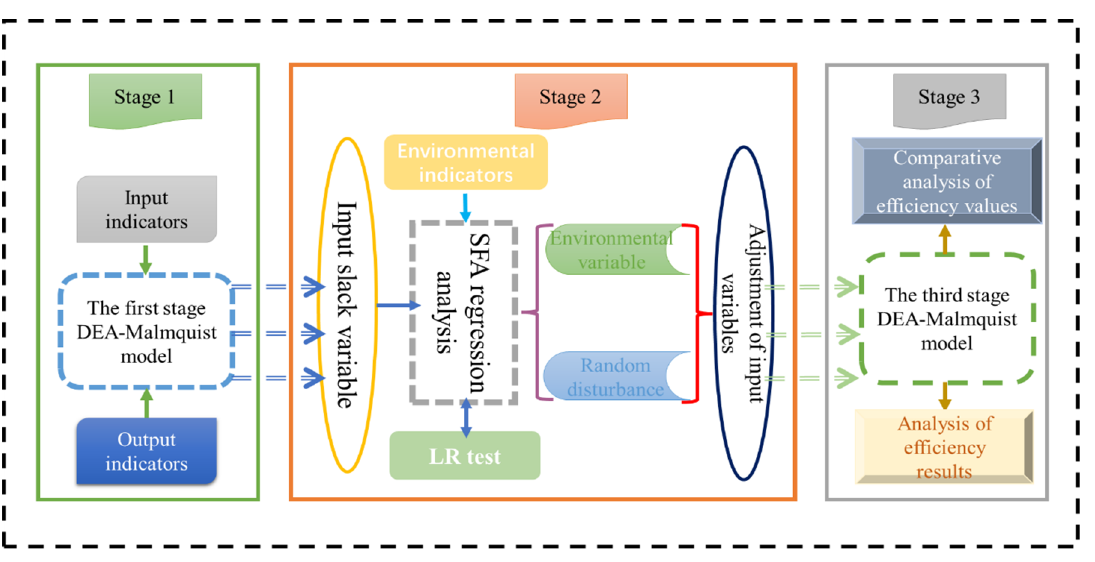
Figure 2. Research methods for determining the agricultural efficiency in the YREB.